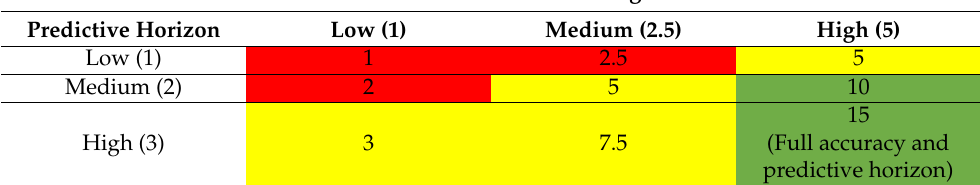
Table 5. Prognosis priority index. Precision of Deterioration Prognosis and RUL Prediction Predictive